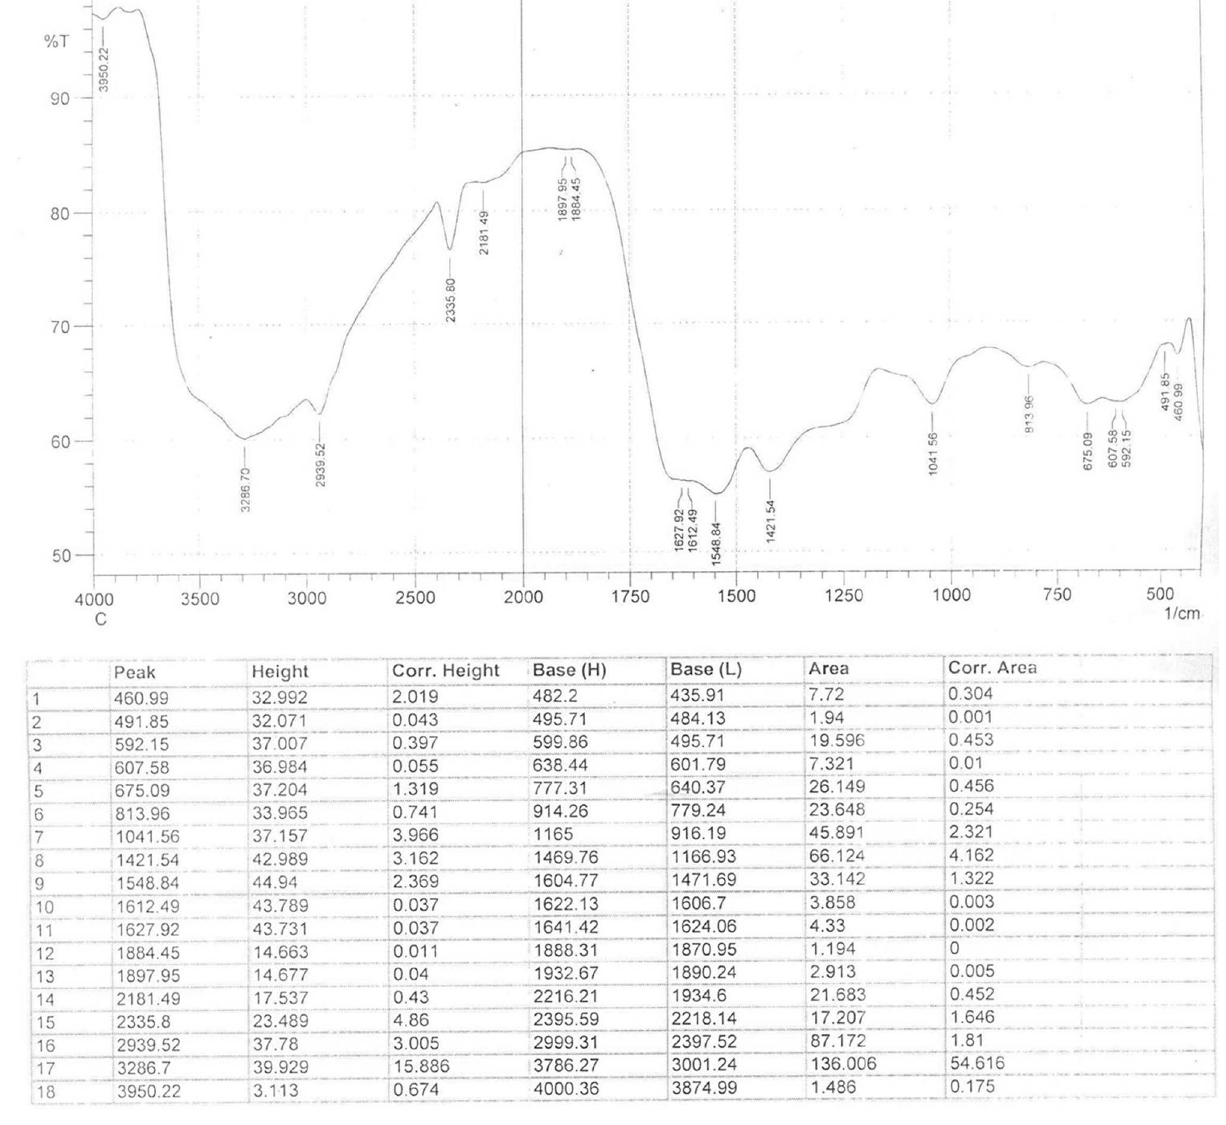
Frontiers in Plant Science |